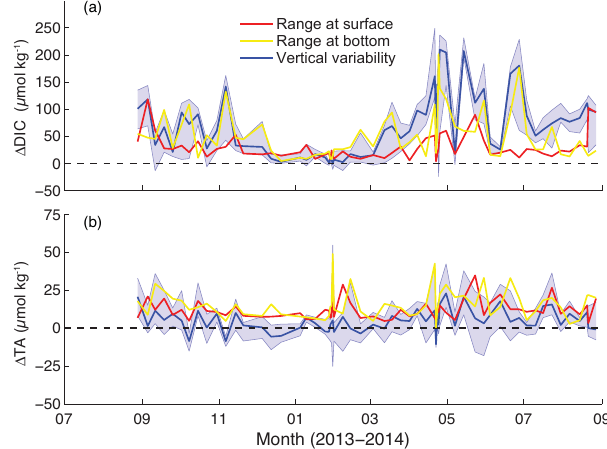
Figure 6. Variability throughout the sampling period for (a) DIC and (b) TA. The range of surface values across all six sites is shown in red, and the range of bottom values across all six sites is shown in yellow. The blue line is the median surface-to-bottom difference in DIC or TA during a given sampling day, and the blue shaded region represents the maximum and minimum vertical gradients observed on each day. Note the differences in scale between (a) and (b)